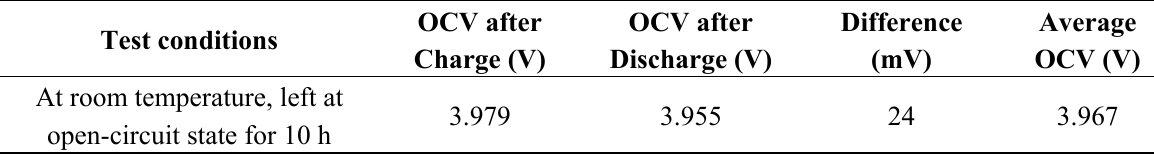
Table 1. Comparison of the cell OCV during charging and discharging at SOC = 0.5. OCV after OCV after Test conditions At room temperature, left at open-circuit state for 10